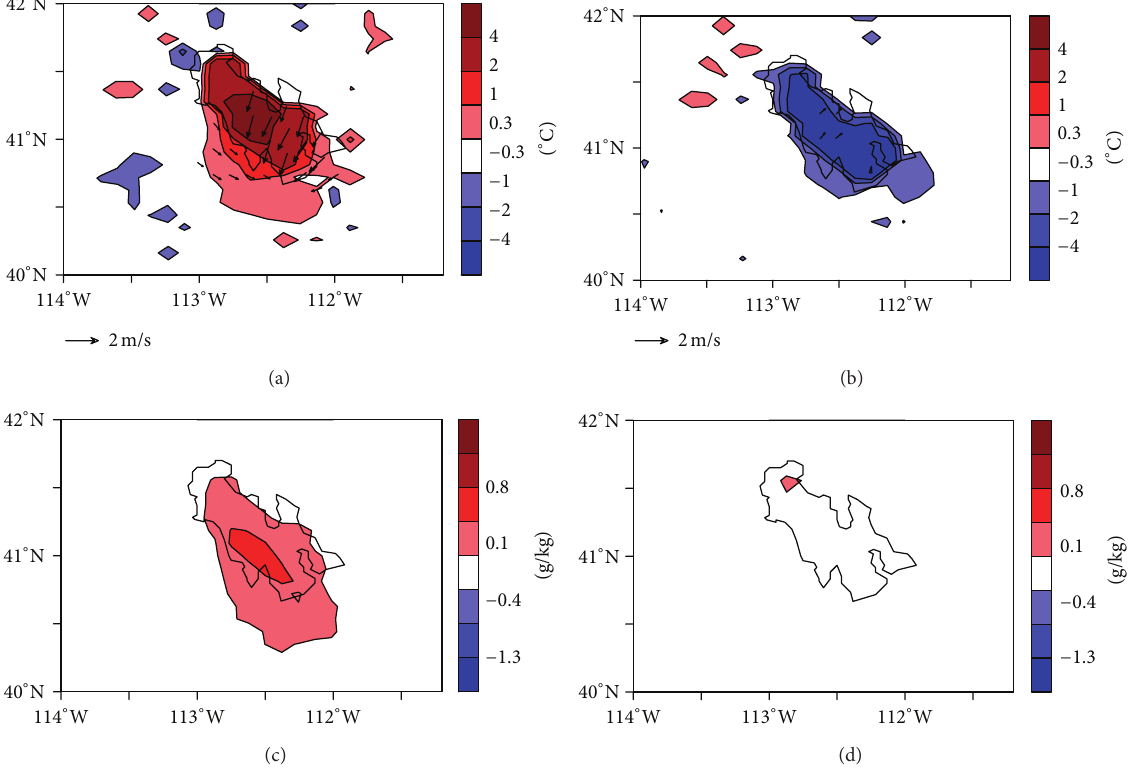
Figure 12: Simulated surface horizontal wind difference and difference of surface skin temperature ((a), (b)) between SL and NL (a) and between FL and NL (b), and simulated vertical wind difference over 800 hPa and simulated humidity difference near surface ((c), (d)) between SL and NL (c) and between FL and NL (d) in the second GSL precipitation